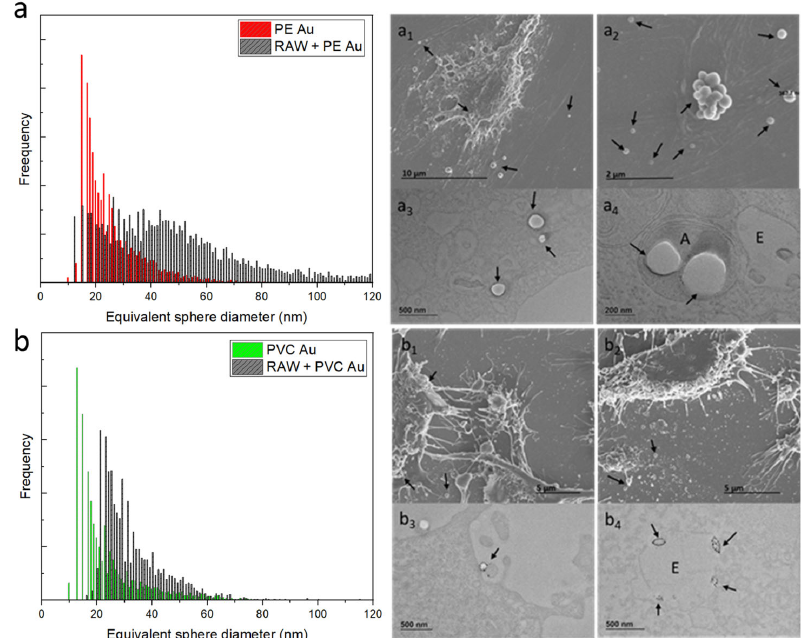
Figure 5. ( a ) Equivalent sphere diameter distribution of PE Au (red) and RAW 264.7 cells incubated with PE Au for 48 h (black) at a concentration of 100 μ g mL − 1 . ( a 1 , a 2 ) The SEM image of the RAW 264.7 cells, incubated with PE Au for 48 h, reveals the presence of nanoplastics, both interacting with the cell membrane and as background materials. ( a 3 , a 4 ) The TEM image of the slices of RAW 264.7 cells after 48 h of incubation with PE Au, displaying the presence of PE Au (arrows), confirming the internalization into the amphisomes (A). ( b ) Equivalent sphere diameter distribution of PVC Au (green) and RAW 264.7 cells, incubated with PVC Au for 48 h (black) at a concentration of 100 μ g mL − 1 . Both the SEM ( b 1 , b 2 ) and TEM ( b 3 , b 4 ) analyses of the sample display the presence of nanoplastics, both internalized and interacting with the cell membrane or as a background material. Particles are visible on the cell membrane and inside the endosome (E), also confirming the presence of Au NPs inside PVC Au by TEM (arrows). The same experiment has also been carried out with CaCo ‐ 2 cells, which were incubated with PE Au and PVC Au at a concentration of 100 μ g mL − 1 and then analyzed by both scICP ‐ MS and electron microscopy. Similarly to the case of the RAW 264.7 cells, exposing the CaCo ‐ 2 cells to a concentration of nanoplastics that was two orders of magnitude higher contributed to an increase in the rate of uptake, which was absent when the lower, environmentally relevant concentrations were employed. In this case study, the scICP ‐ MS analyses and electron microscopy observations were also in good agreement. Indeed, Figure 6a shows the scICP ‐ MS distribution of PE Au and CaCo ‐ 2 cells incubated with PE Au, which display a partial superposition, meaning that most of the